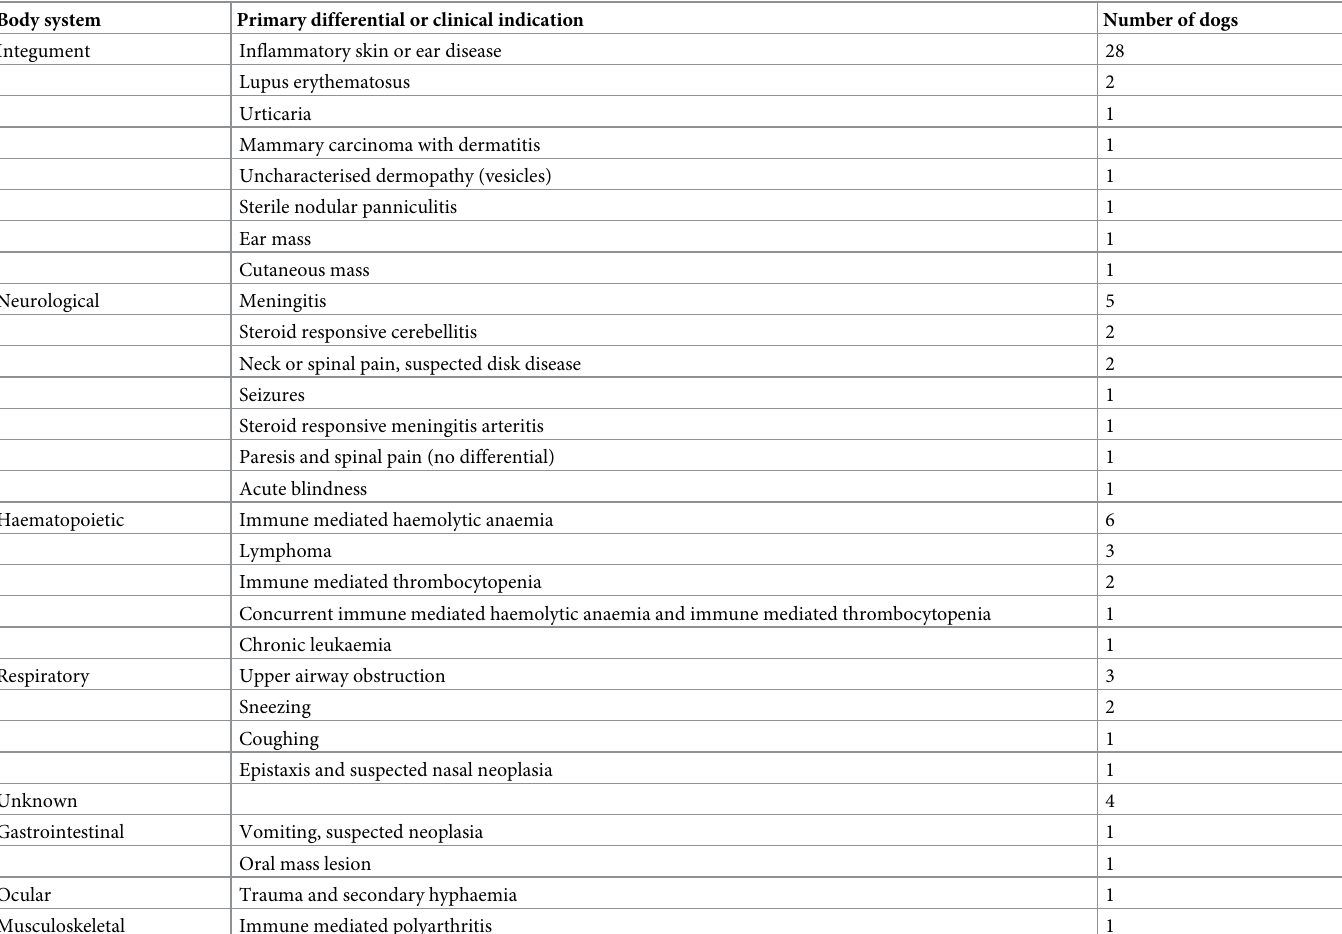
Table 5. Indication for prednisolone in Australian dogs receiving � 2mg/kg/day of prednisolone ( n = 77). Body